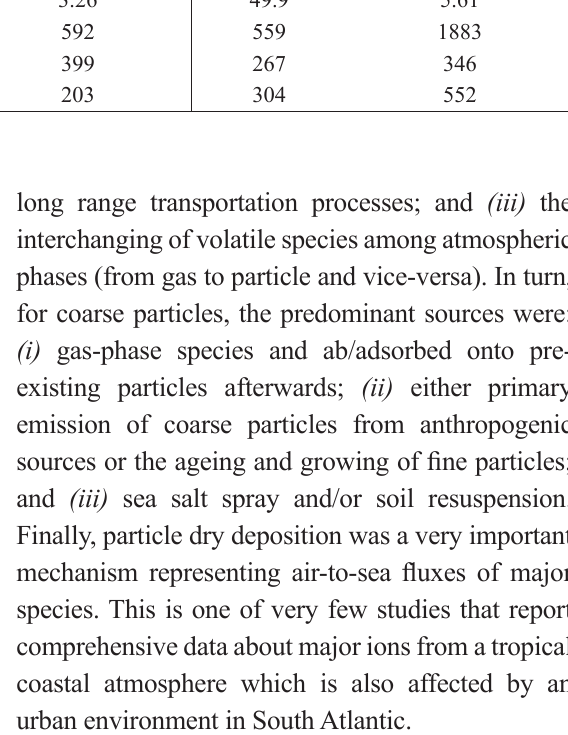
Estimates of particle dry deposition fluxes (F